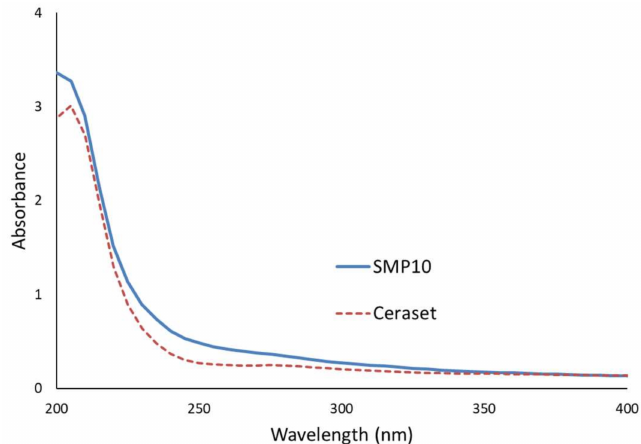
Figure 2. UV-vis absorbance of carbosilane SMP10 and silazane Ceraset (0.05 wt % in